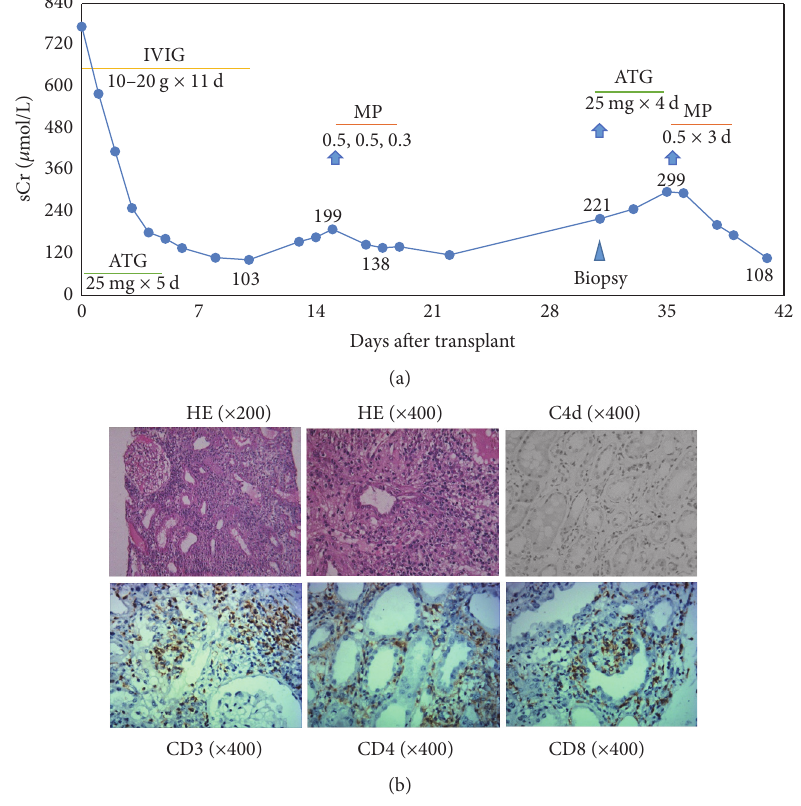
Figure 3: The clinical course of a second graft recipient who had early acute TCMR twice after transplantation. A 47-year-old male patient received his second kidney transplantation. (a) Early clinical course after retransplantation: renal graft gained immediate function with serum creatinine (sCr) levels decreasing rapidly and reaching normal levels at day 7. Increased sCr was observed at around day 14 and 3 doses of Methylprednisolone (MP, 500 mg/d) were then administered. After treatment, sCr levels decreased to 117 𝜇 mol/L at day 23 and then were elevated again (221 𝜇 mol/L) at day 31, and a biopsy was performed. sCr levels returned to normal after treatment with Thymoglobulin (25 mg/d) for 4 days and subsequent MP (500mg/d) for 3 days. (b) Pathological results indicated acute TCMR, Banff 2007 grade IIA (i3, t2, v1, and g0), with extensive T-cell infiltration (positive staining for CD3, CD4, and CD8) and negative C4d